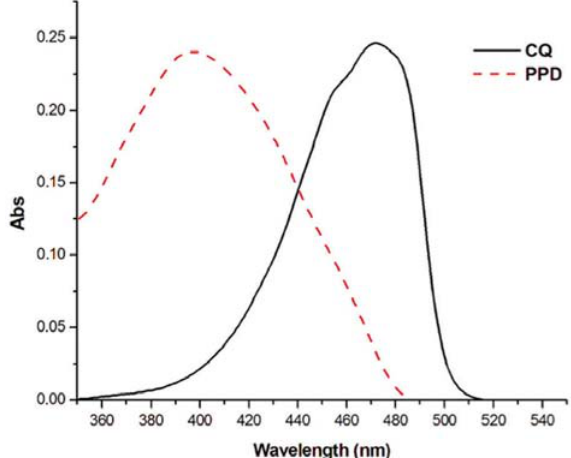
Figure 1- Absolute irradiance (mW/cm 2 /nm) x wavelength (nm) for each light-curing unit tested